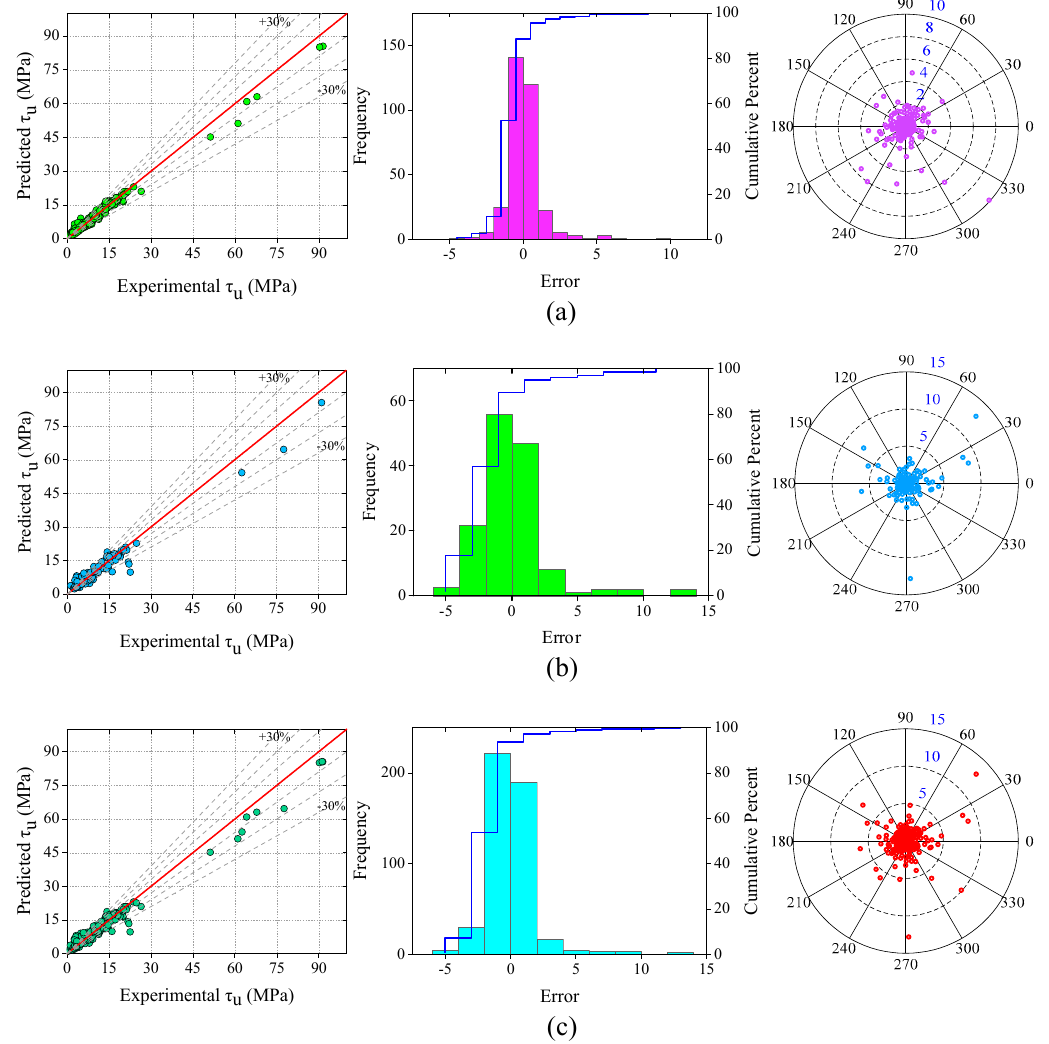
Figure 12. Scatter plot, frequency distribution, and absolute error of proposed SVM model; ( a ) training dataset, ( b ) testing dataset, and ( c ) overall dataset.